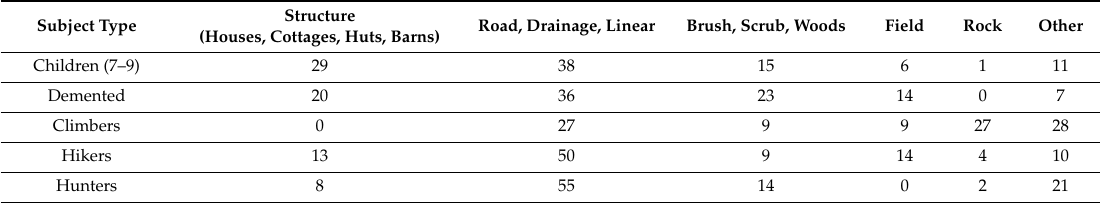
Table 1. Statistical data about subject type and location where missing persons have been